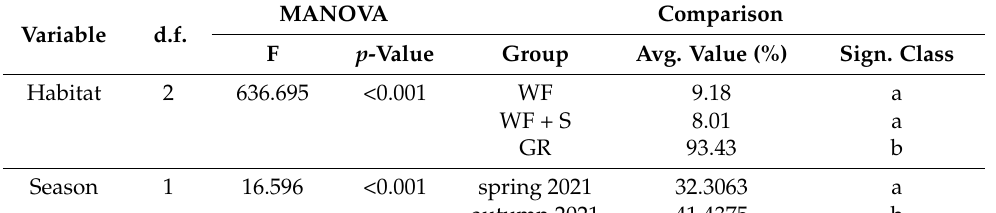
Table 3. Effect of habitat and season on vegetation (total cover; ˝Osag á rd, Hungary).